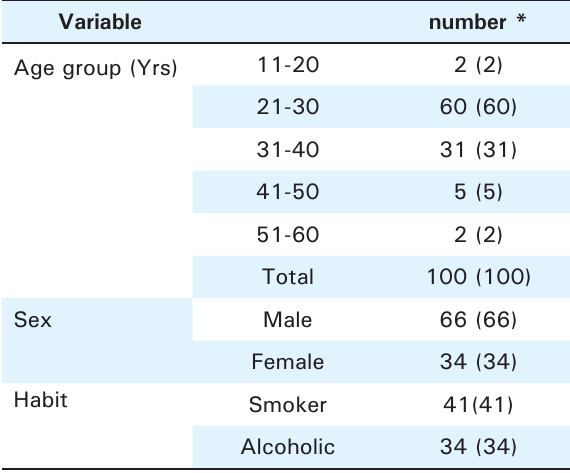
Table 1. Socio-demographic Characteristics of